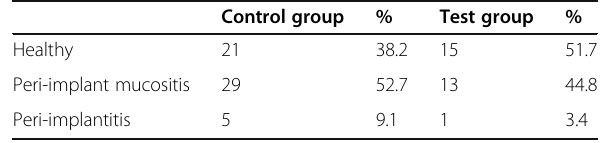
Table 4 Prevalence of peri-implant disease (implant level) Control